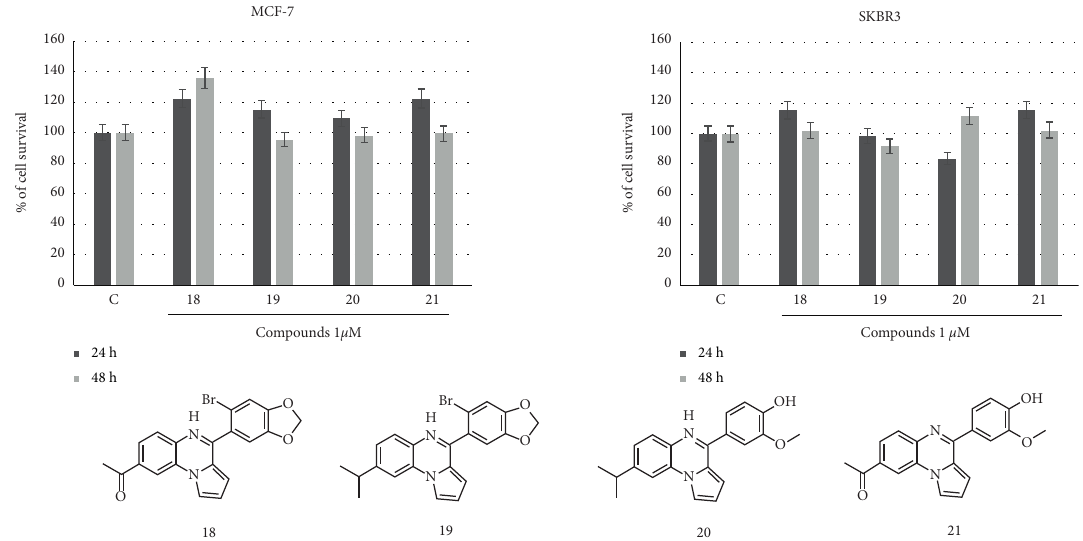
Figure 3: Effects compounds on breast cancer growth. MTTgrowth assays in MCF-7 and SKBR3 cells were treated with 1 μ M of 18, 19, 20, and 21 compounds for 24 and 48 hours. Untreated cells are denoted with control (C). Cell proliferation is the representative of three different experiments, each performed in triplicate.